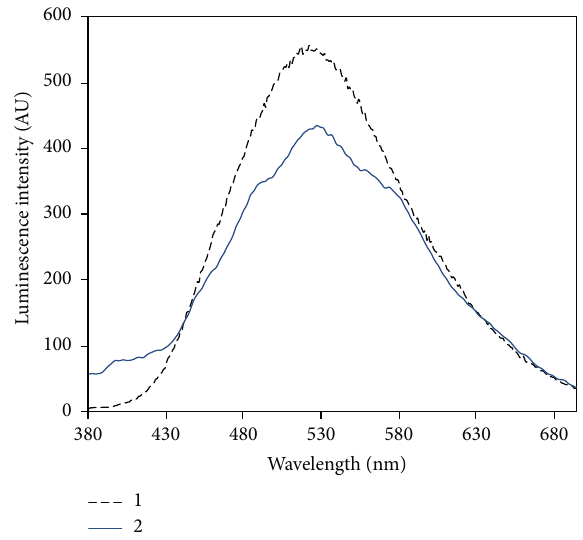
Figure 1: The luminescence spectra of 1: colloidal solution of ZnO/SiO 2 nanoparticles in a liquid state, [ZnO] = 2 ⋅ 1 0 −2 mol/L; 2: printing ink with ZnO/SiO 2 nanoparticles and PVP in a liquid state. 𝜆 exc . = 330 nm.